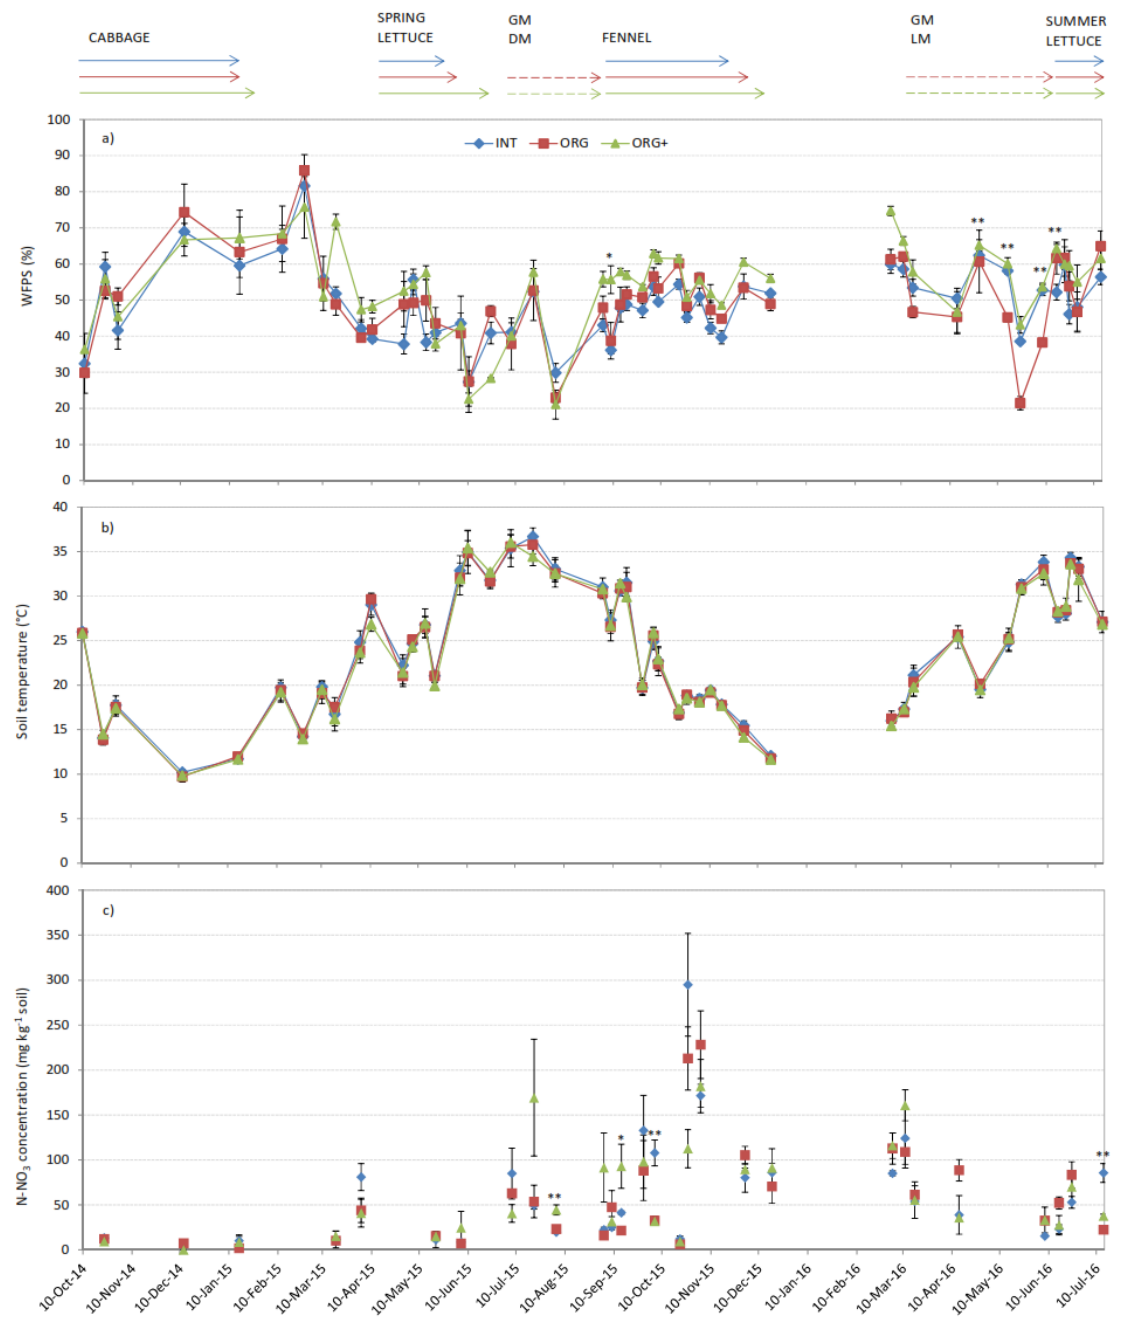
Figure 4. Data recorded in F2: ( a ) Soil WFPS; ( b ) soil temperature; ( c ) soil nitrate (N–NO 3 ) concentration for each treatment. Simple arrows indicate fertilization events; dashed arrows the primary tillage of each crop. On field 1 (F1) the temporal crop sequence was: Cabbage, spring lettuce, fennel, then summer lettuce. Significance was as follows: n.s. is not significant; * is significant at the p ≤ 0.05 level; ** is significant at p ≤ 0.01 level.